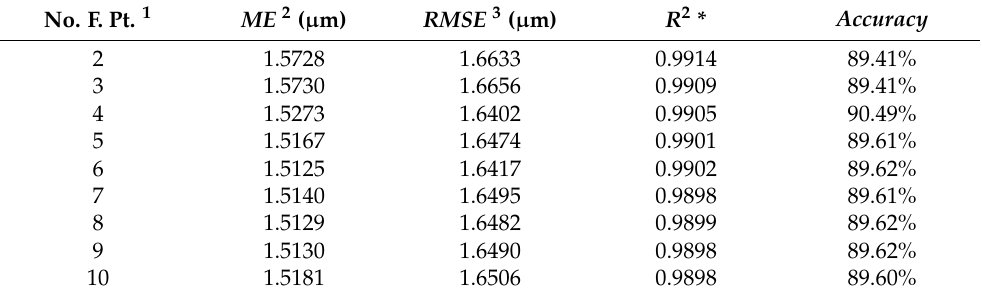
Table 4. The influence of the number of the feature temperature points on the external validation result of the thermal error model trained through RF under variable speed